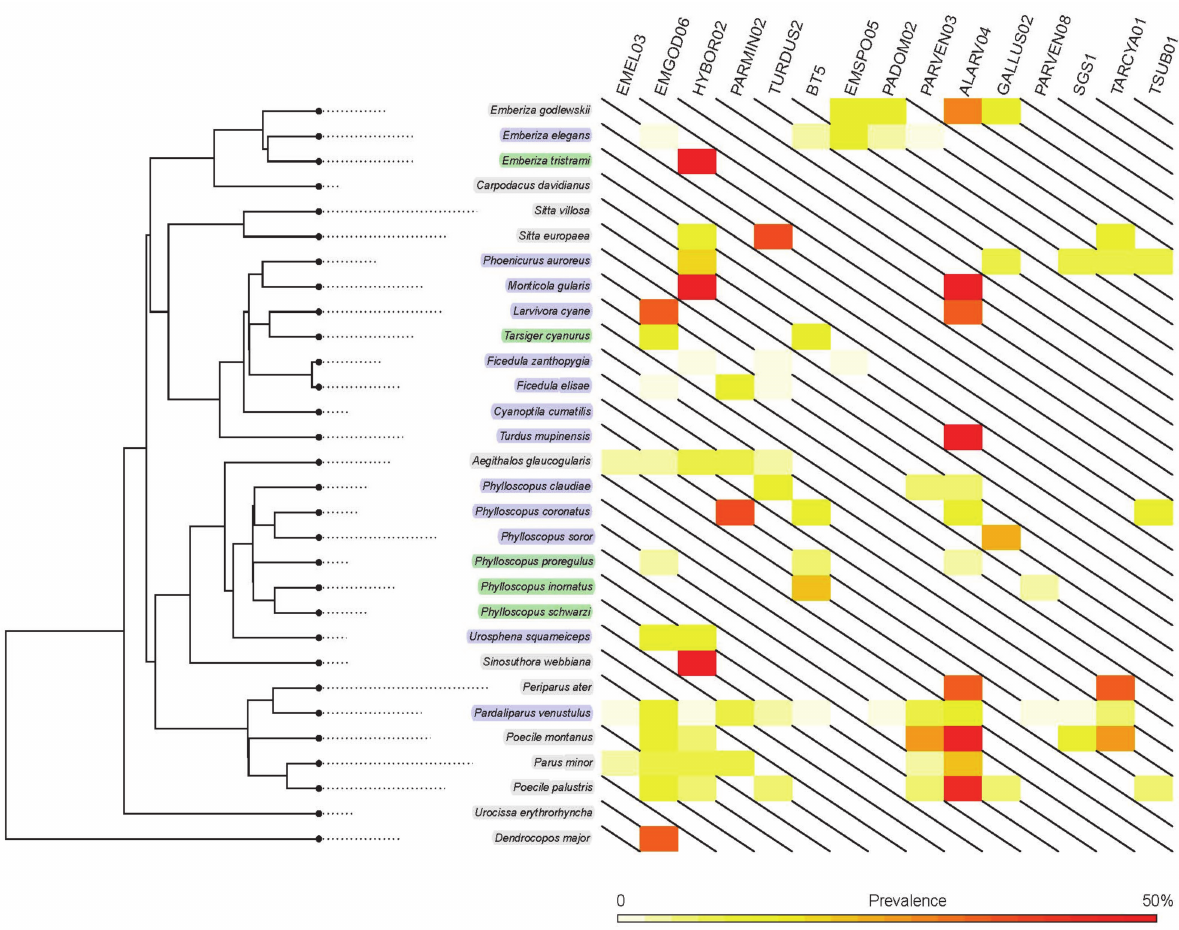
Figure 2. Phylogenetic tree of the bird species collected in this study. Species belonging to three groups are marked in distinct colors (resident: gray, migration: purple, and passing: green). The heatmap on the right panel represents the prevalence of the shared lineages in different host